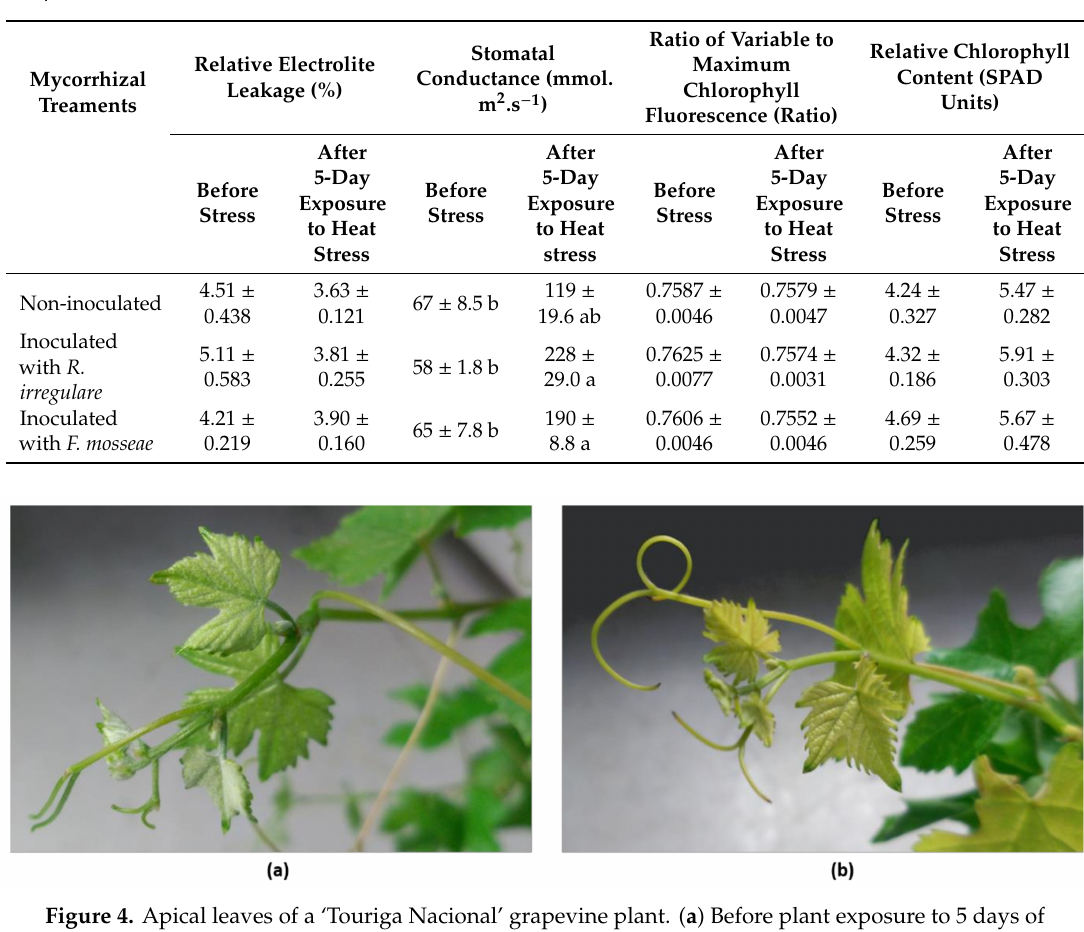
Table 3. Measurements of physiological parameters in plants inoculated or not with mycorrhizal fungi and exposed or not to a long-term heat stress treatment. Values indicate mean ± standard error (n = 5). Di ff erent letters indicate significant di ff erences in group means according to pairwise multiple comparisons conducted using the simulation method of Edwards and Berry [70]. Significant e ff ect, p -value < 0.05.